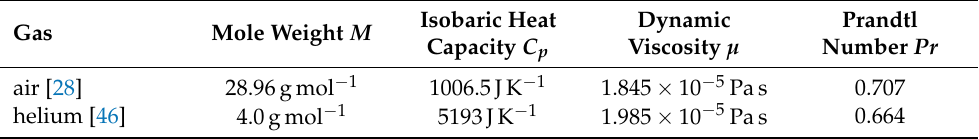
Table A1. Applied material properties of air and helium.